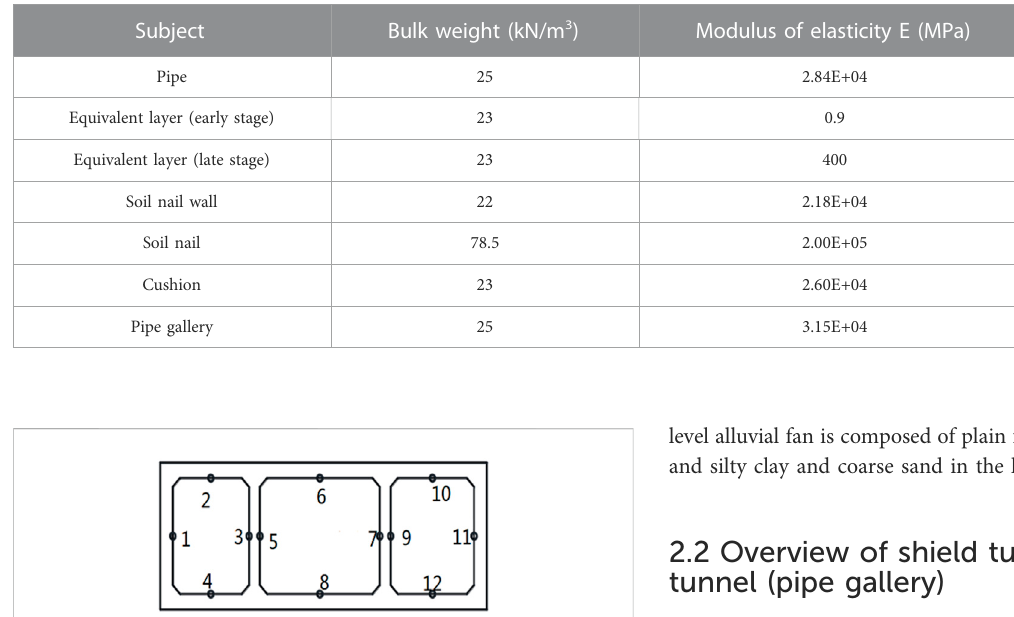
TABLE 5 Structural parameters of subway tunnel and pipe gallery.